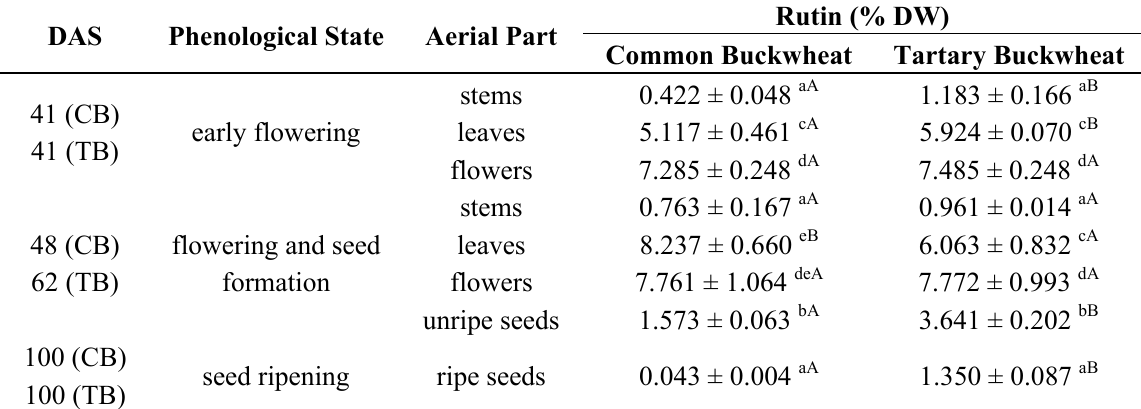
Table 2. Phenological state and rutin content (% DW ± SD) in the aerial parts of common (CB) and tartary (TB)